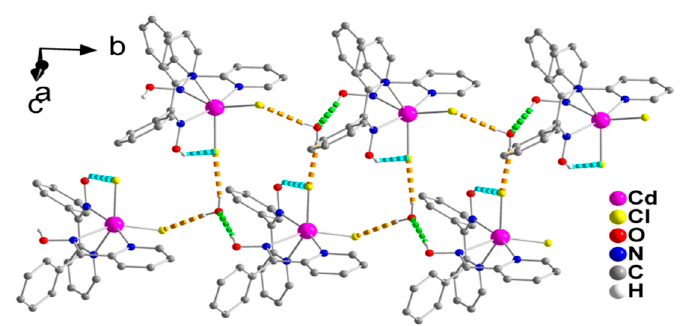
Figure 3. A small portion of one double chain, formed through hydrogen bonds, in the crystal structure of 1 · H 2 O. The dashed light green and dashed cyan lines represent the hydrogen bonds O1-H(O1) ··· O1W(x, − 1 + y, z) and O11-H(O11) ··· Cl1(x, y, z), respectively. The dashed orange lines represent the hydrogen bonds O1W-H A (O1W)-Cl2(x, y, z) and O1W-H B (O1W) ··· Cl1( − x, 0.5 + y, 0.5 − z). For clarity, only hydrogen atoms involved in hydrogen bonding interactions are shown.